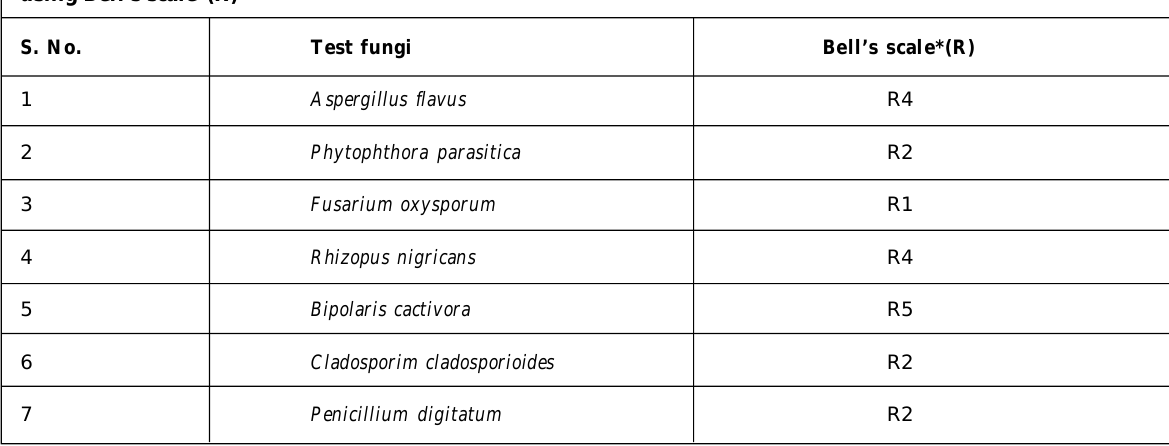
Table 2: Evaluation of Trichoderma harzianum against fruit rots pathogens by dual culture using Bell’s